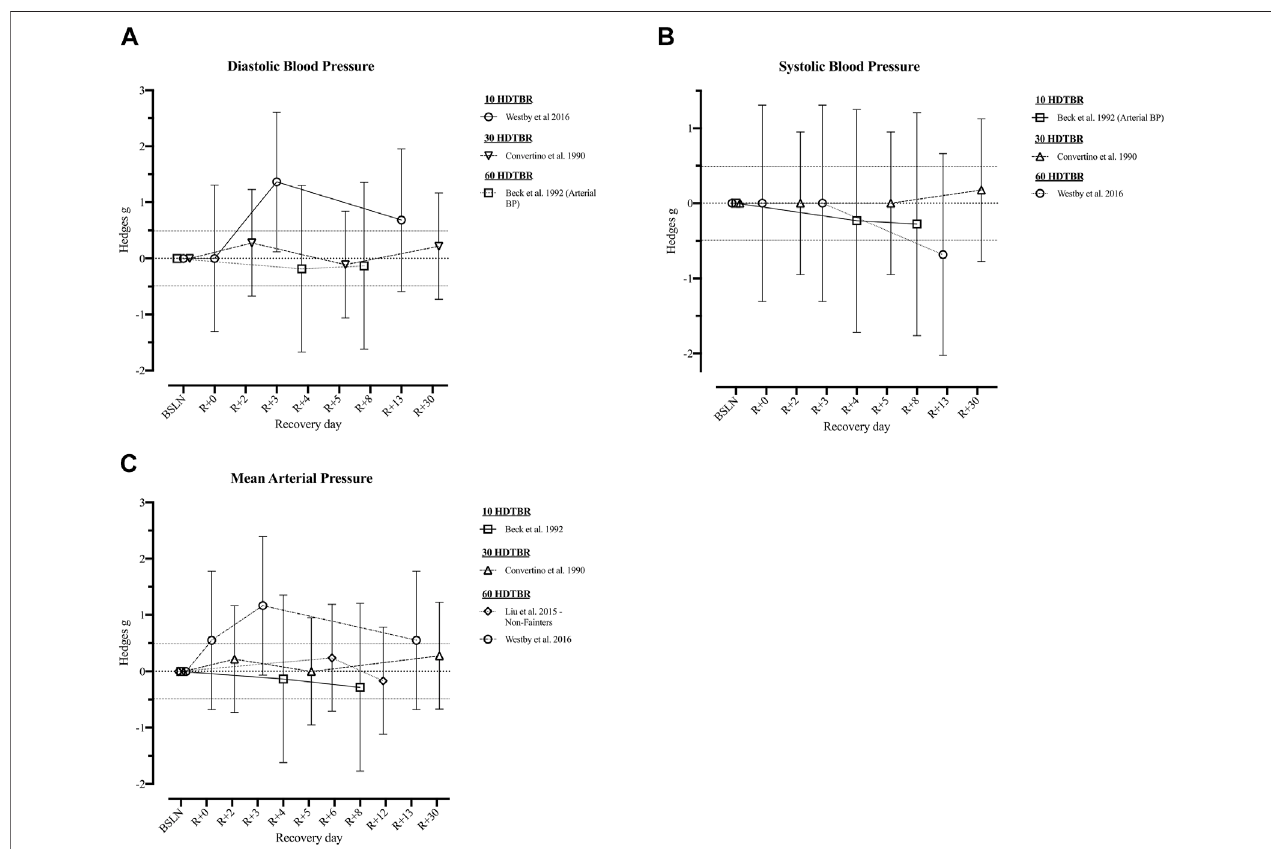
FIGURE5| Visualisationoftherecoveryofoutcomesrelatedtothe ‘ Cardiovascular System ’ (Part2)afteraperiod ofhead-down-tilt bedrest,displayed asHedges g with 95% Con fi dence Interval. (A) Recovery of the Diastolic Blood Pressure (B) Recovery of the Systolic Blood Pressure (C) Recovery of Mean Arterial Pressure. To determine whether a particular outcome could be deemed as “ recovered ” during the recorded recovery period, the Westlake ’ s Con fi dence Interval Procedure (Seaman and Serlin, 1998) was used. This procedure tests for equivalence between two means using a con fi dence interval. To do so, Upper (0.49) and Lower ( − 0.49) equivalency bounds of interest were determined, corresponding to the limit of a small effect size. When combined with the 95% Con fi dence Interval of the Hedges g , three scenarios are possible: 1) No evidence of recovery : It cannot be concluded that the difference between means is trivial as the 95% Con fi dence Interval falls completely outside the set equivalency bounds; 2) Weak evidence of recovery : The results are inconclusive as the 95% Con fi dence Interval partially falls within the set equivalency bounds, thus including both trivial and non-trivial differences. The dotted lines at 0.49 and − 0.49 represent the upper and lower equivalency bounds; 3) Strong evidence of recovery: There is practical equivalence as the 95% Con fi dence Interval falls completely within set equivalency bounds; 10 HDTBR: Included studies implementing a head-down-tilt bed rest period of 10 days (Westby et al., 2016); 30 HDTBR: Included studies implementing a head-down-tilt bed rest period of 30 days (Convertino etal.,1990);60HDTBR:Includedstudies implementingahead-down-tiltbedrestperiod of60 days(Becketal.,1992;Liuetal.,2015;Westbyetal.,2016); R+ ... : Respective recovery day; Arterial BP : Arterial systolic and diastolic Blood Pressure.